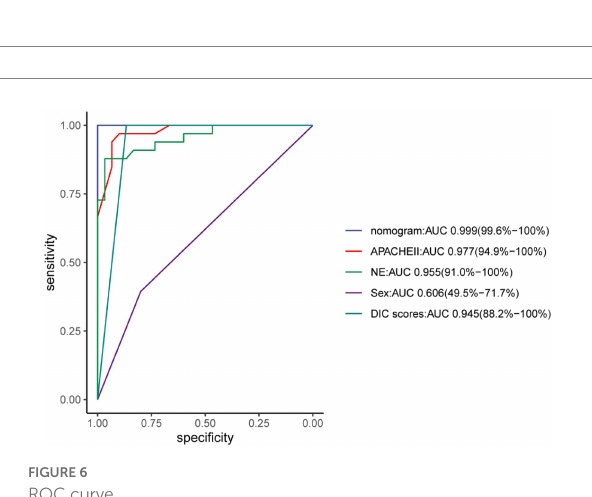
FIGURE 5 DCA curve.